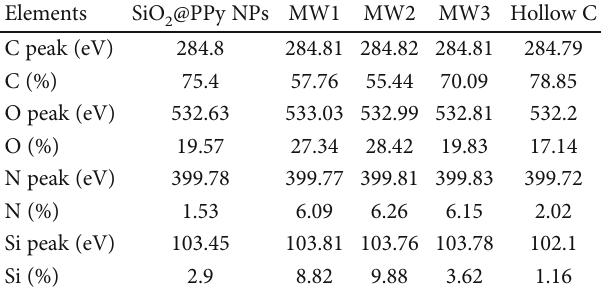
Figure 5: XPS results of SiO and Hollow C. Table 3: The atomic percentages and peak positions of di ff erent elements obtained by XPS characterization of SiO samples after microwave, and Hollow